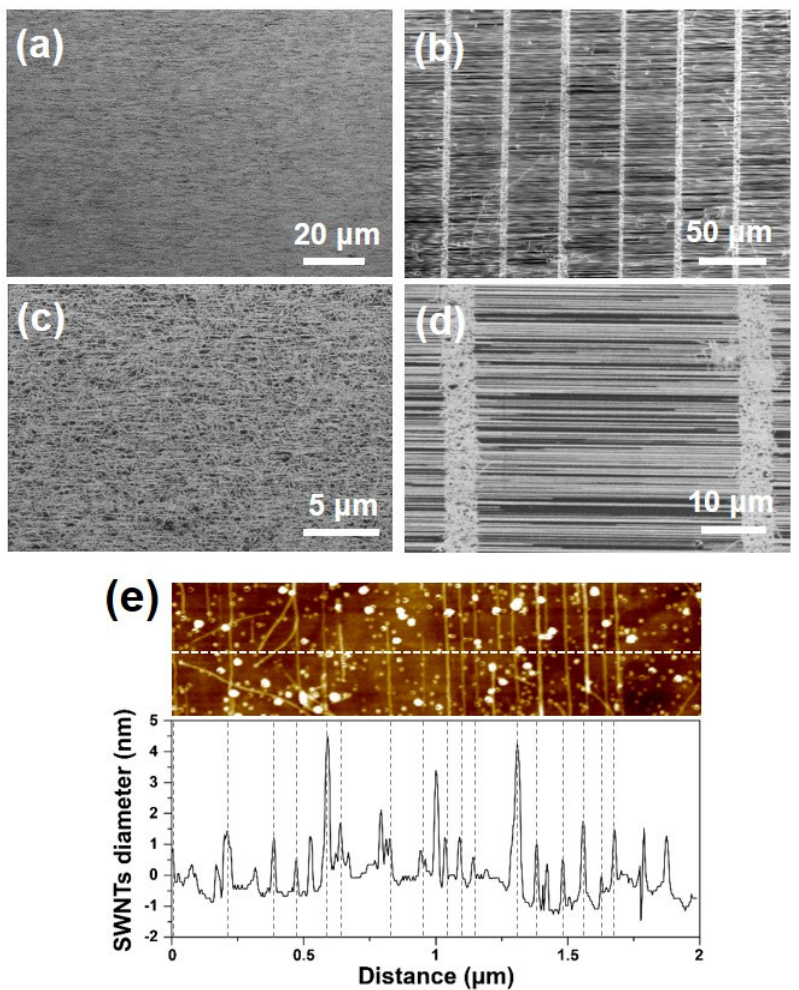
Figure 7. SEM images of SWNTs taken at the central region of plain ( a , c ) and line-patterned ( b , d ) ST-cut quartz wafers. ( e ) AFM topographic image and corresponding height profile result from ( d ). The sample was grown at 900 °C with H 2 :CH 4 = 25:225 sccm.